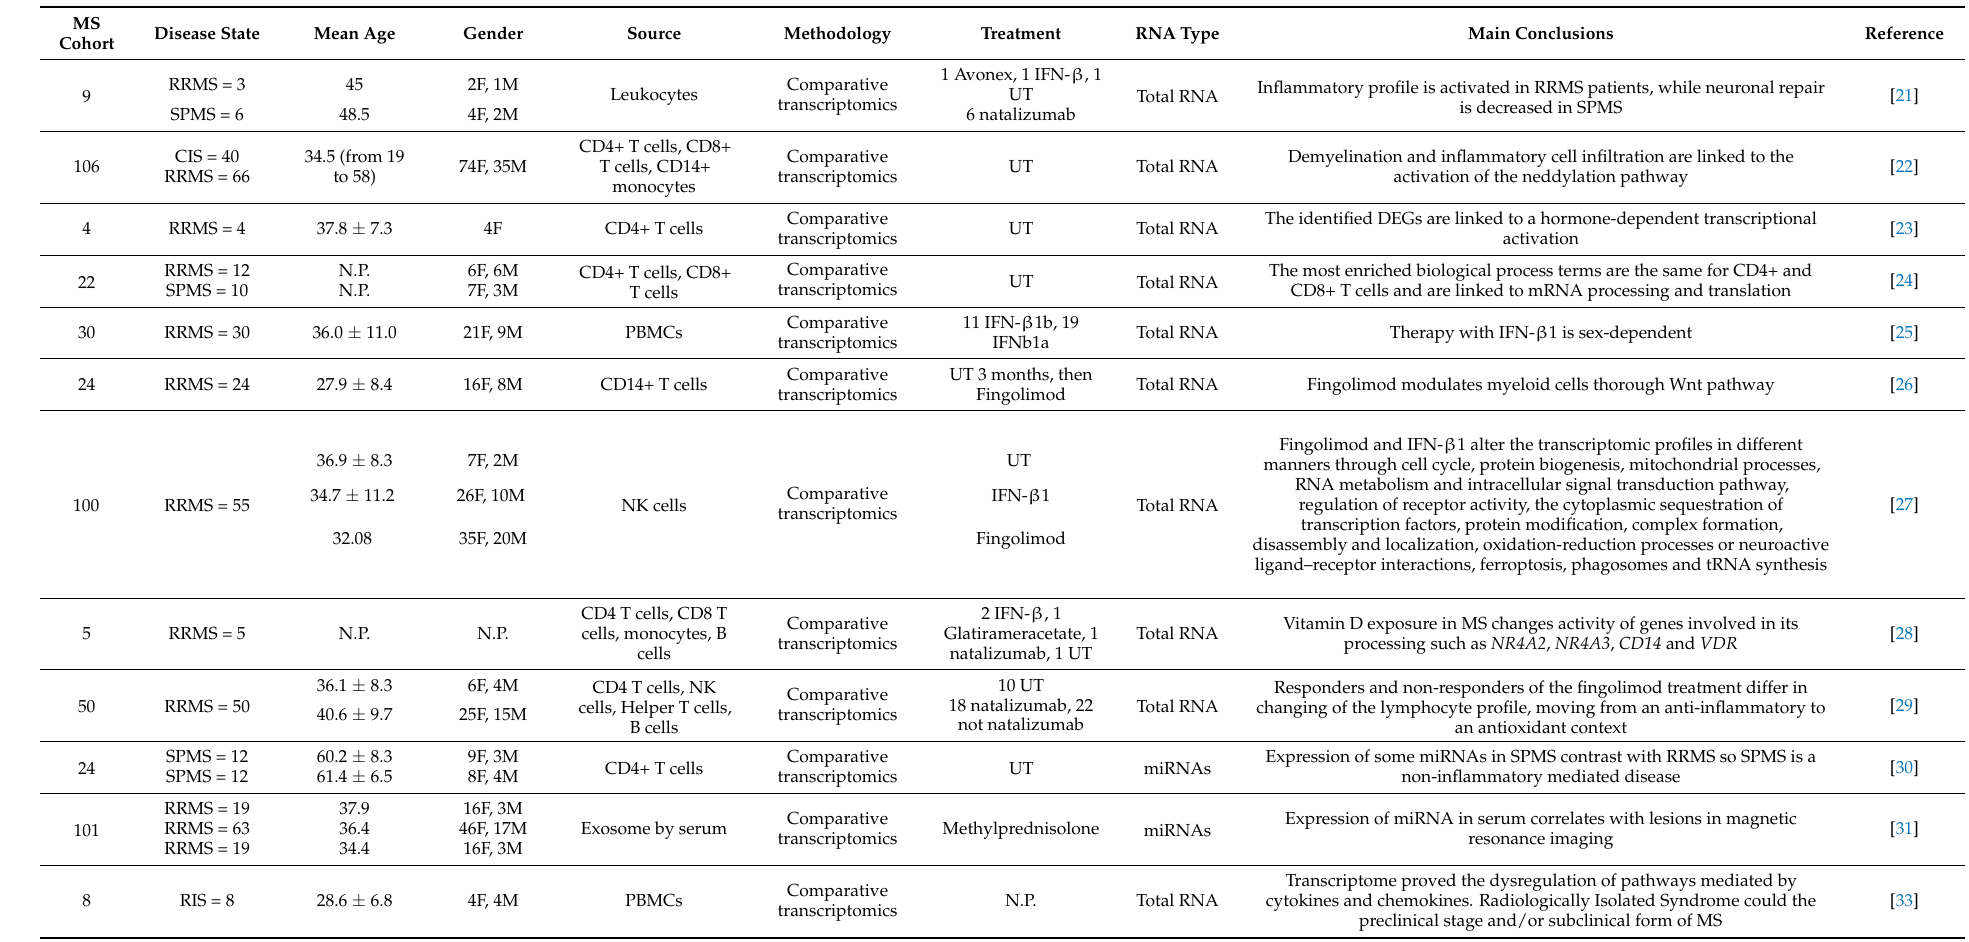
Table 1. Overview of the studies exploring transcriptomes in human